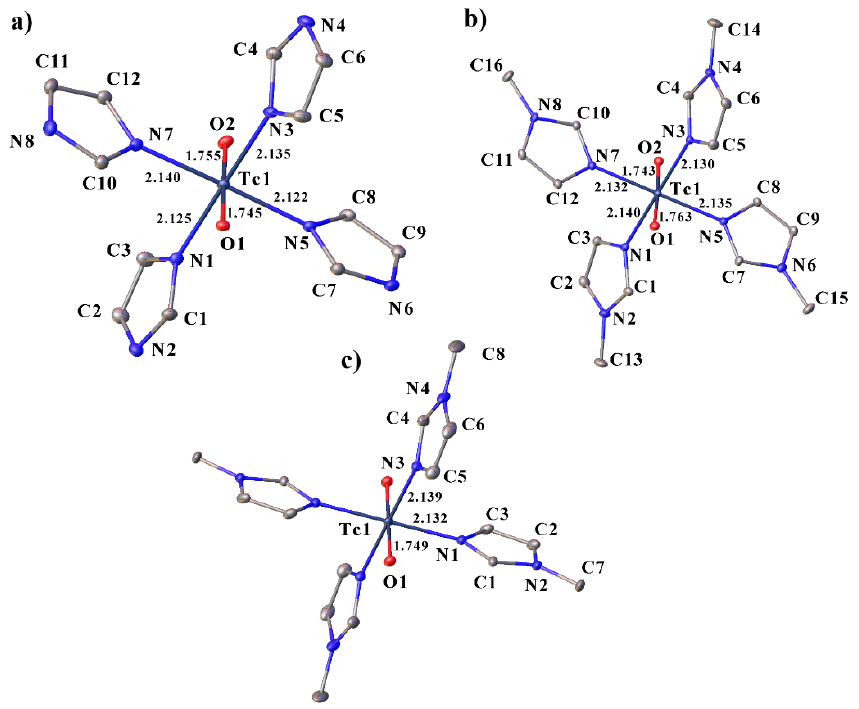
Figure 1. Molecular structure of II ( a ), III ( b ) and IV ( c ) showing the coordination of the technetium atom with some bond lengths and labeling. Solvent molecules, counterions and H-atoms are omitted for clarity.